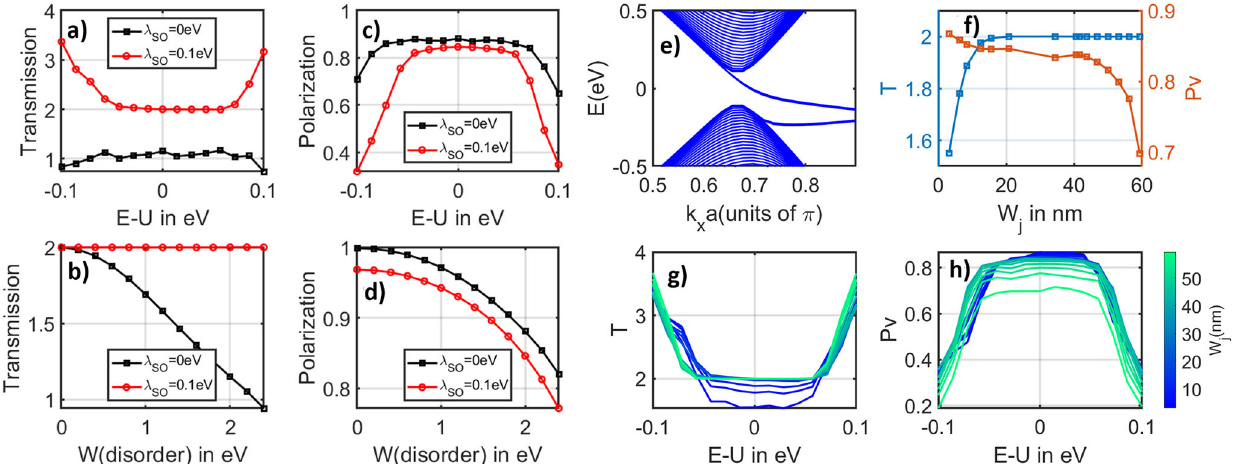
Fig. 7 Comparison of valley fi ltering ef fi ciency for the cases with ( λ SO = 0.1 eV) and without ( λ SO = 0 eV) SO coupling when subjected to the same dual gate voltage. a , c T and Pv versus E − U for W = 2 eV. b , d T and Pv versus W for E − U = 0 eV. e Band structure for W j ≈ 60 nm, the interface states move toward the X -point of the Brillouin zone. f Variation of T and Pv w.r.t W j for W = 2 eV and E − U = 0 eV. T shows droop at low W j because of increased tunneling between the interface states whereas Pv shows droop at high W j as the interface states move away from the K and K 0 points. g , h Variation of T and Pv w.r.t E − U for different values of W j as depicted by the color bar and W = 2 eV. For intermediate values of W j we expect the best performance in terms of both T and Pv